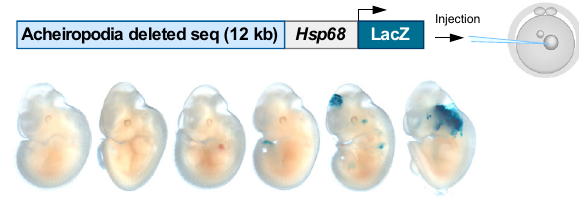
Fig. 2 Mouse transgenic enhancer assay for the 12 kb acheiropodia- associated sequence. Schematic representation of the mouse transgenic enhancer assay (upper panel) showing the 12 kb acheiropodia-associated sequence cloned upstream of the Hsp68 promoter-LacZ gene. Enhancer activity, as visualized by LacZ staining, was not observed in the ZPA for the six PCR positive E11.5 mouse embryos (lower